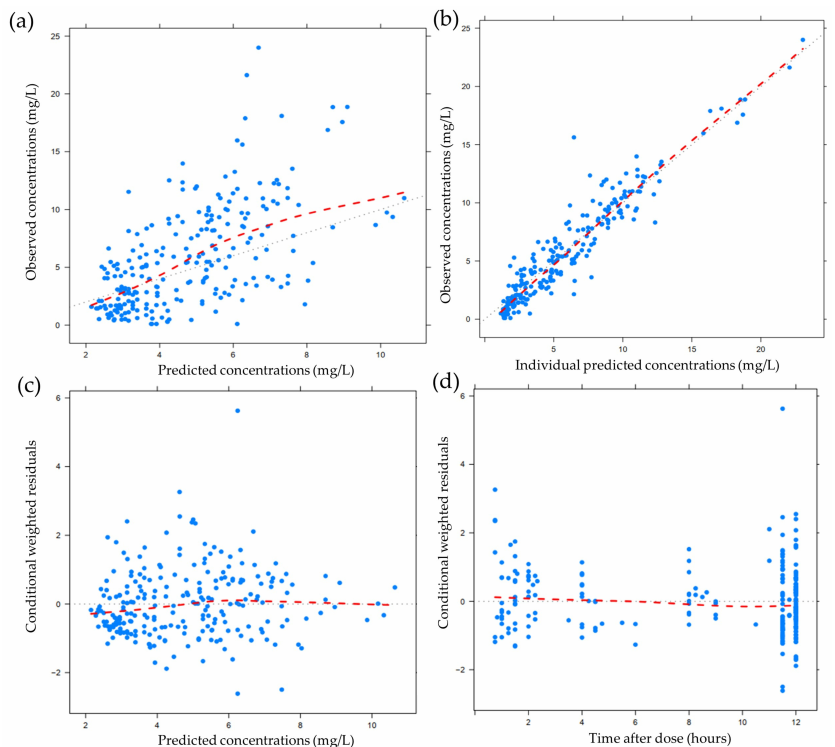
Figure 1. Goodness-of-fit (GOF) plots for the final model. ( a ) Population-predicted concentration (PRED) versus observed concentration; ( b ) Individual predicted concentration (PRED) versus observed concentration; ( c ) Conditional weighted residuals (CWRES) versus PRED; ( d ) CWRES versus time after dose; The red lines in ( a ) and ( b ) show regression lines, and in ( c ) and ( d ) they show the positive where CWRES equals 0.